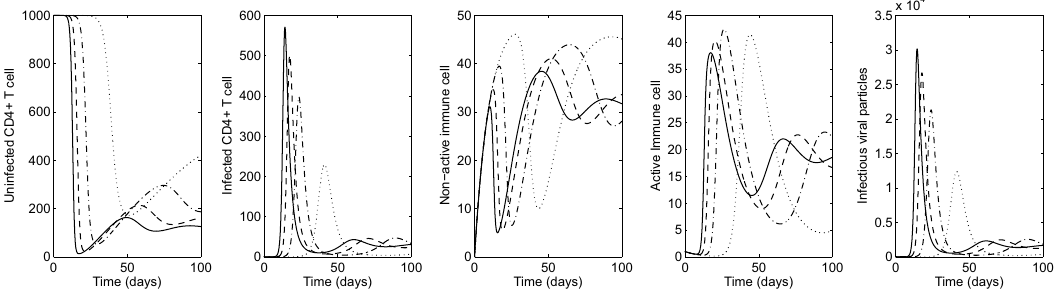
Figure 2. Early-stage HIV dynamics in the absence of controls under four different values of β ( γ = 0.002 is fixed): β = 0.000015 (dotted), β = 0.000025 (dash-dot): β = 0.000035 (dashed) and β = 0.000045